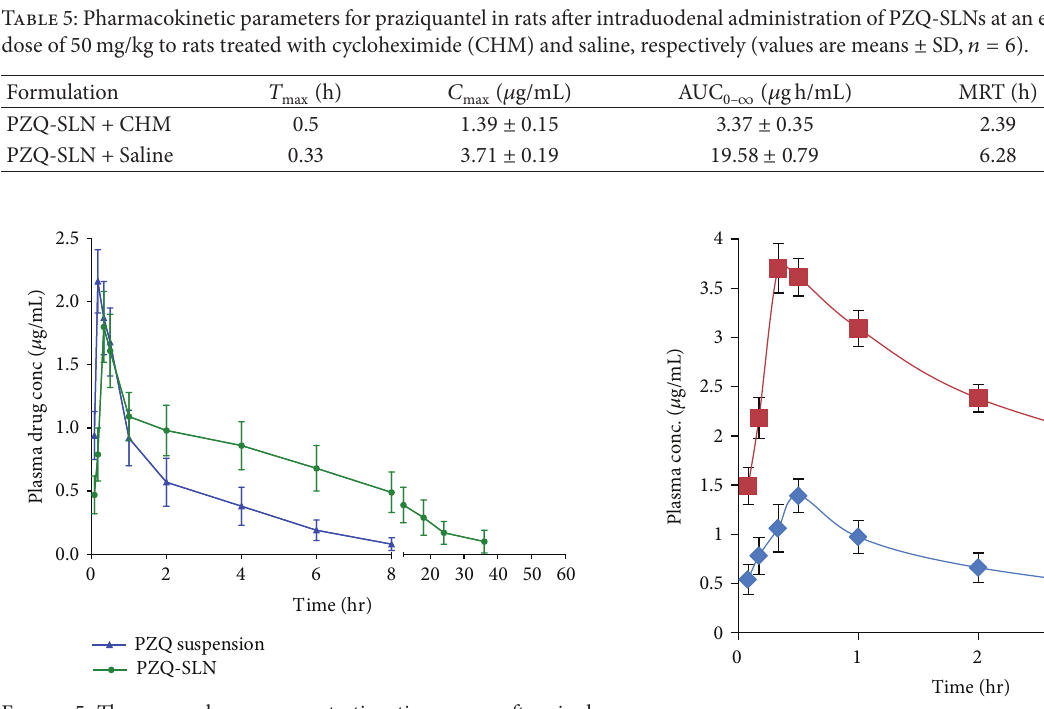
Figure 5: The mean plasma concentration-time curve after single oral administration of PZQ-SLN (F25) and PZQ suspension (0.5% w/v methyl cellulose suspension of pure PZQ) in rats (50 mg/kg) (values are means ± SD, 𝑛 = 6 ). Figure 6: The mean plasma concentration-time curve after single intraduodenal administration of PZQ-SLN and PZQ suspension (0.5% w/v methyl cellulose suspension of pure PZQ) in rats (50 mg/kg) (values are means ± SD, 𝑛 = 6